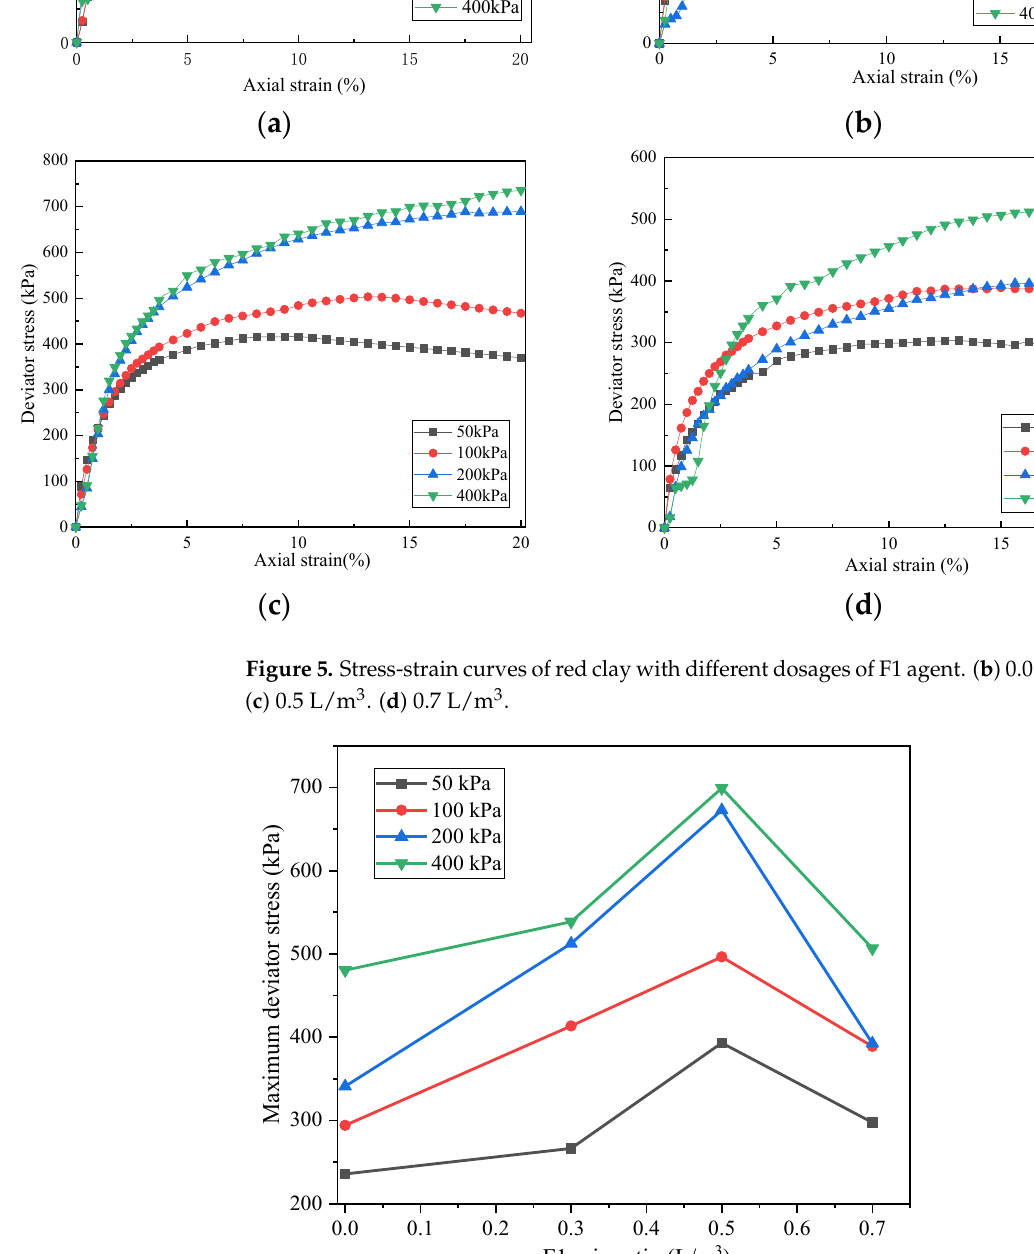
Figure 5. Stress-strain curves of red clay with different dosages of F1 agent. ( b ) 0.0 L/m 3 . ( b ) 0.3 L/m 3 . ( c ) 0.5 L/m 3 . ( d ) 0.7 L/m 3 .